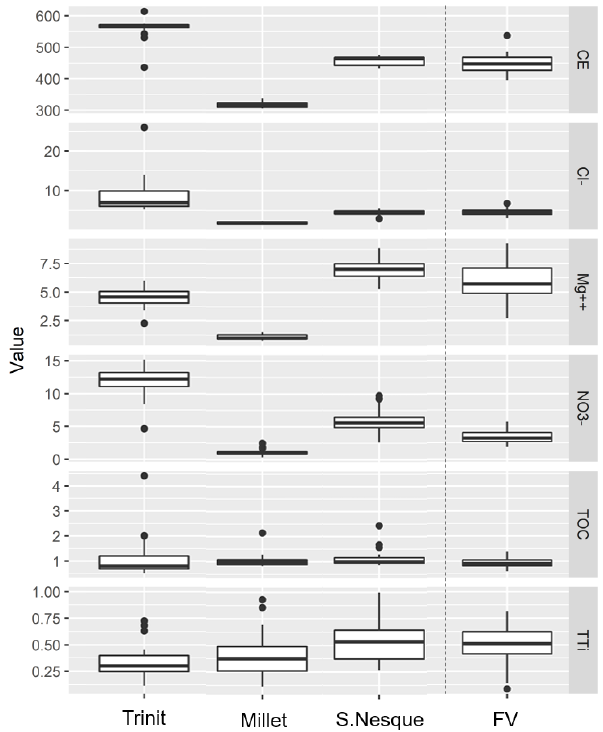
Figure 7. Box plots of electrical conductivity, chlorides, magne- sium, nitrates, TOC, and TTi of Fontaine de Vaucluse (FV, 25 sam- ples), Millet (27 samples), Nesque (S. Nesque, 29 samples), and St Trinit (Trinit, 29 samples)